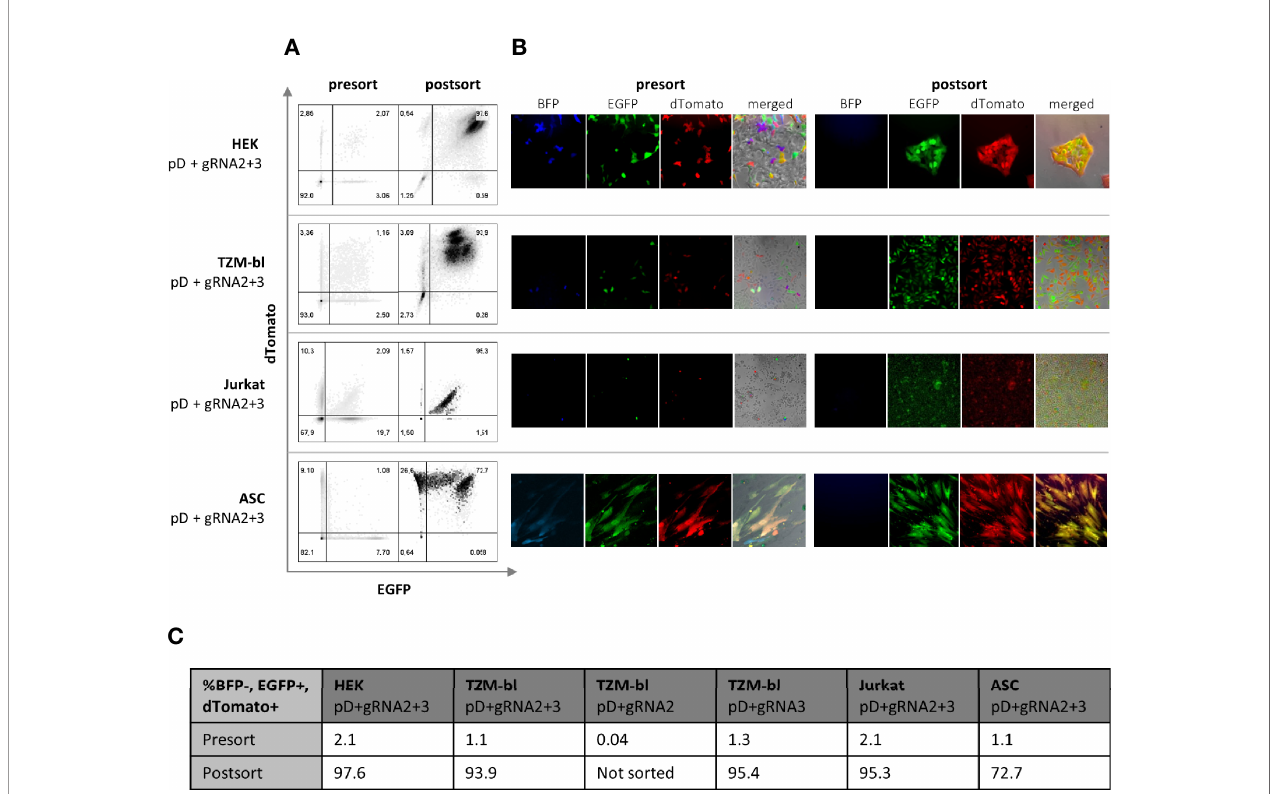
FIGURE 2 | Selection of double positive (BFP-, EGFP+, dTomato+) cells via FACS. Four different cell types (HEK, TZMbl, Jurkat and ASC) have been transfected with both pDonor and both pgRNA-Cas9 14 days prior to sorting. To compare dual to single targeting, TZMbl have been transfected with both pDonors and single pgRNA-Cas9. (A) Cells were sorted for BFP negativity (not shown) and dual positivity for EGFP and dTomato (presort). The sorted population was reanalyzed immediately and 7 days later, prior to conducting the experiments (postsort) (B) Flourescent microscopy of cells 14 day post transfection (presort) and 7 days after sorting for double positivity (postsort) (C) Quanti fi cation of BFP-, EGFP+ and dTomanto+ cells before and 7 days after sorting. To compare dual to single targeting, TZMbl have additionally been transfected with both pDonors and single pCas9-gRNA